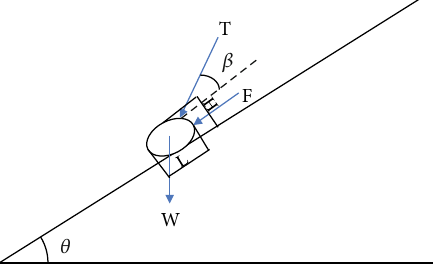
Figure 14: Presents a simpli fi ed diagram of the force on the gravel of the clay gravel